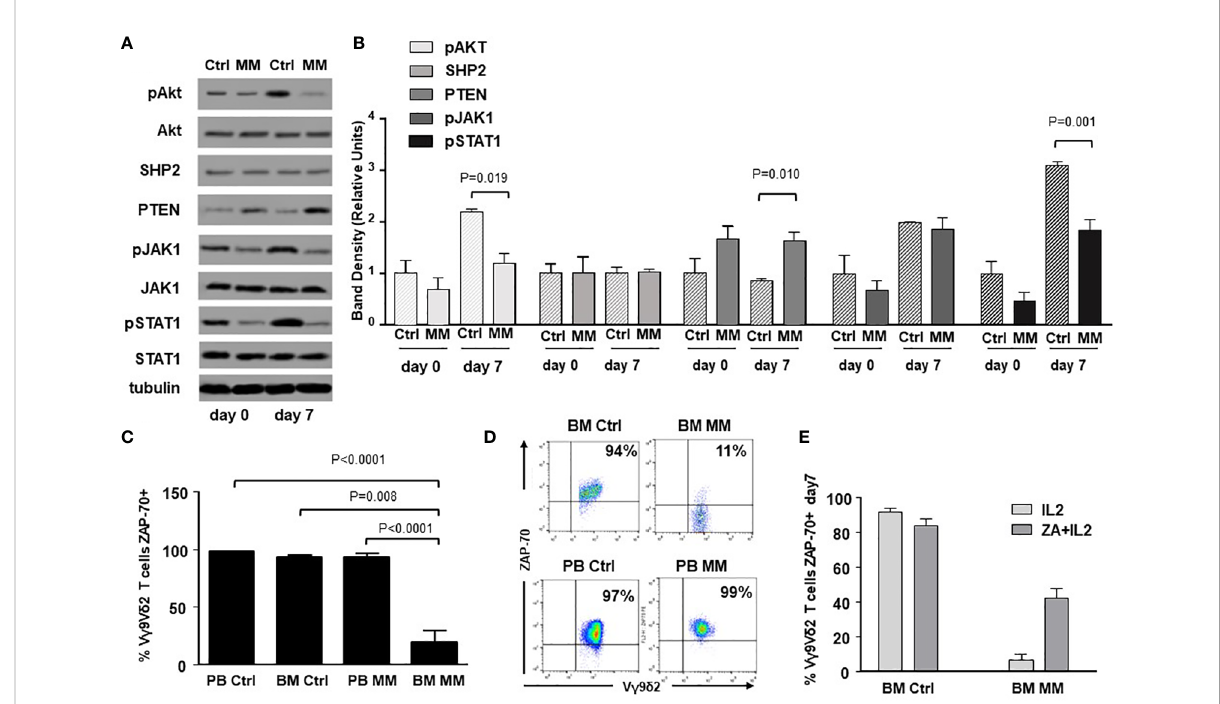
FIGURE 3 Alterations of TCR-associated molecules in BM MM V g 9V d 2 T cells. (A) Western blot analysis of selected TCR-associated molecules (pAKT, AKT, SHP2, PTEN, pJAK-1, JAK-1, pSTAT-1, STAT-1) in puri fi ed resting (day 0) and ZA-stimulated (day 7) BM gd T cells from one representative Ctrl and MM. pAKT, pJAK and pSTAT-1 are down-regulated, whereas PTEN is up-regulated in resting BM MM gd T cells. These differences are ampli fi ed after ZA stimulation (day 7). Tubulin expression is shown to con fi rm equal protein loading per lane. (B) Densitometric analysis of pooled data from ZA-stimulated BM Ctrl and BM MM gd T cells con fi rms lower expression of pAKT, and pSTAT1, and higher PTEN expression in BM MM gd T cells vs BM Ctrl gd T cells. Bars represent mean values ± SE from 1 (BM Ctrl d0 and BM MM d0) to 14 experiments (BM MM). (C) ZAP-70 expression in resting PB and BM V g 9V d 2 T cells from Ctrl and MM patients. Bars represent mean values ± SE from 3 (BM Ctrl) to 25 experiments (BM MM); (D) cyto fl uorimetric analysis of ZAP-70 expression in V g 9V d 2 T cells from BM and PB MM V g 9V d 2 T cells and BM and PB Ctrl; (E) ZAP-70 expression after ZA stimulation in Ctrl and MM BM V g 9V d 2T cells. Bars represent mean values ± SE from 2 (BM Ctrl) to 3 experiments (BM